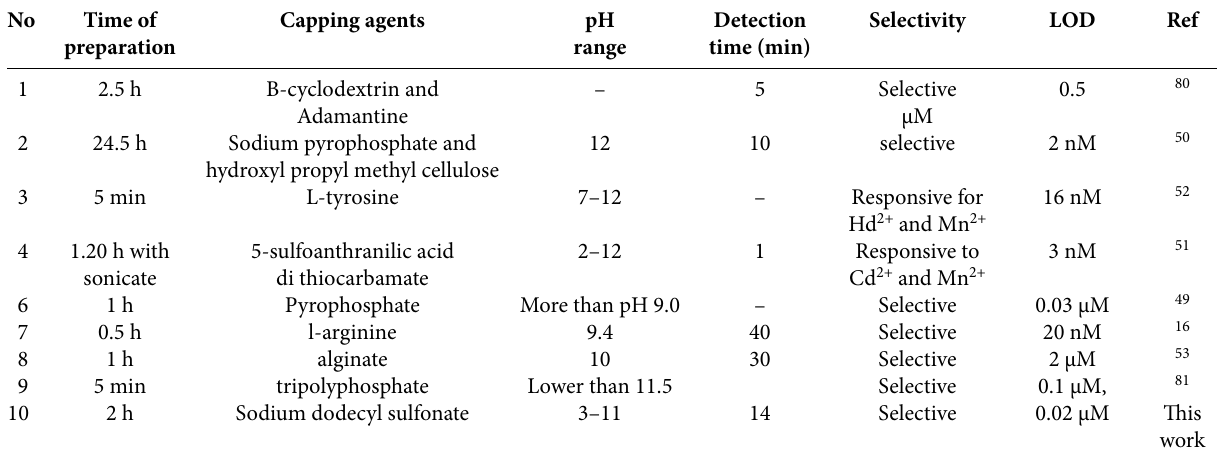
Table 1. Comparison of different methods using AgNPs as a colorimetric sensor for Mn 2+ detection.